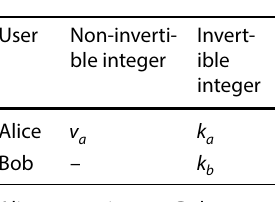
Alice transmits v a to